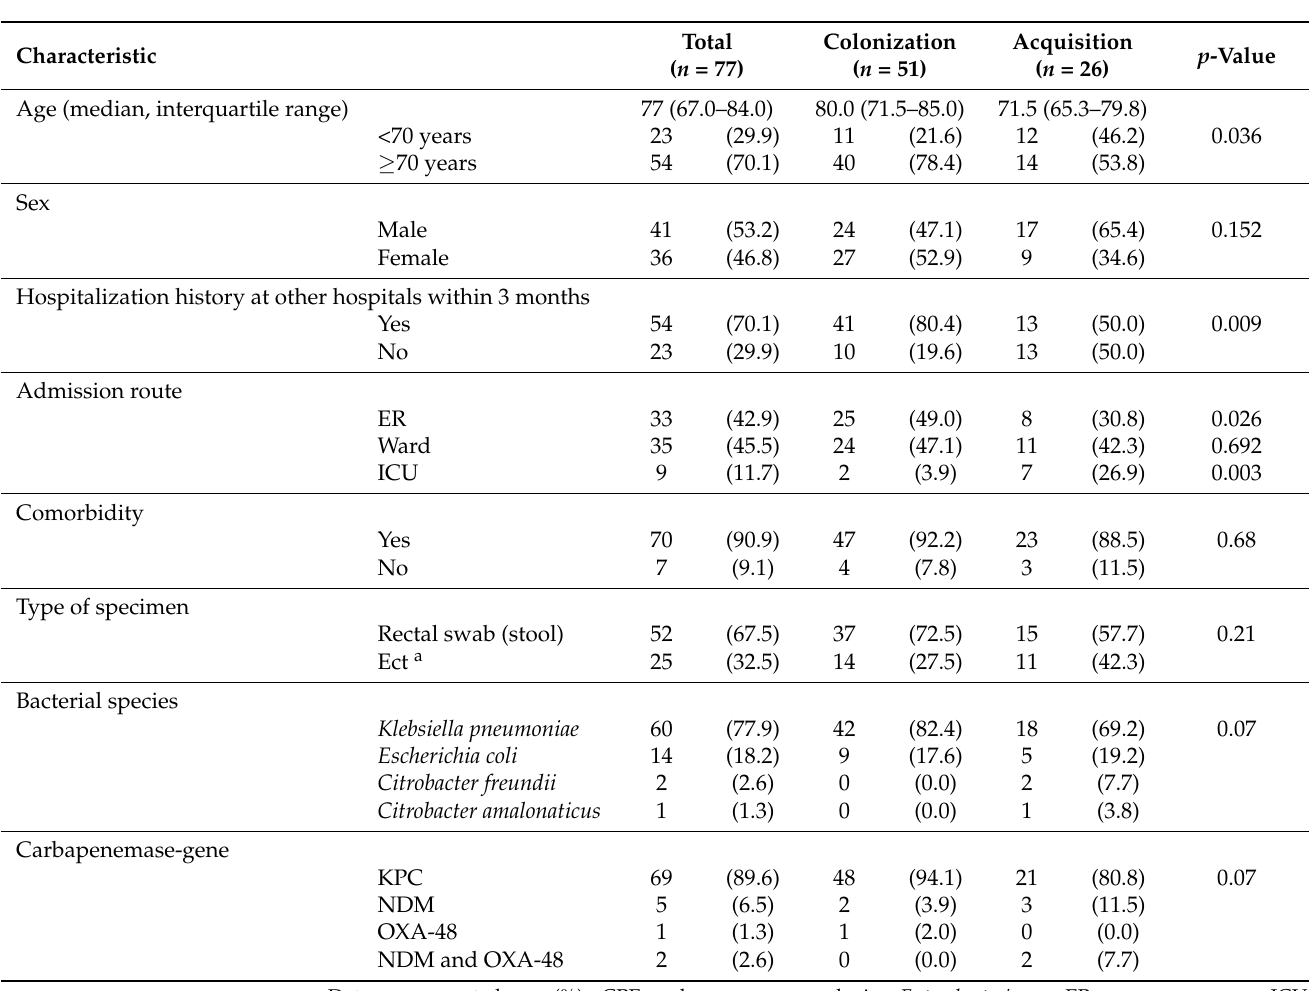
Table 1. Characteristics of patients with CPE infection according to colonization and acquisition ( n =